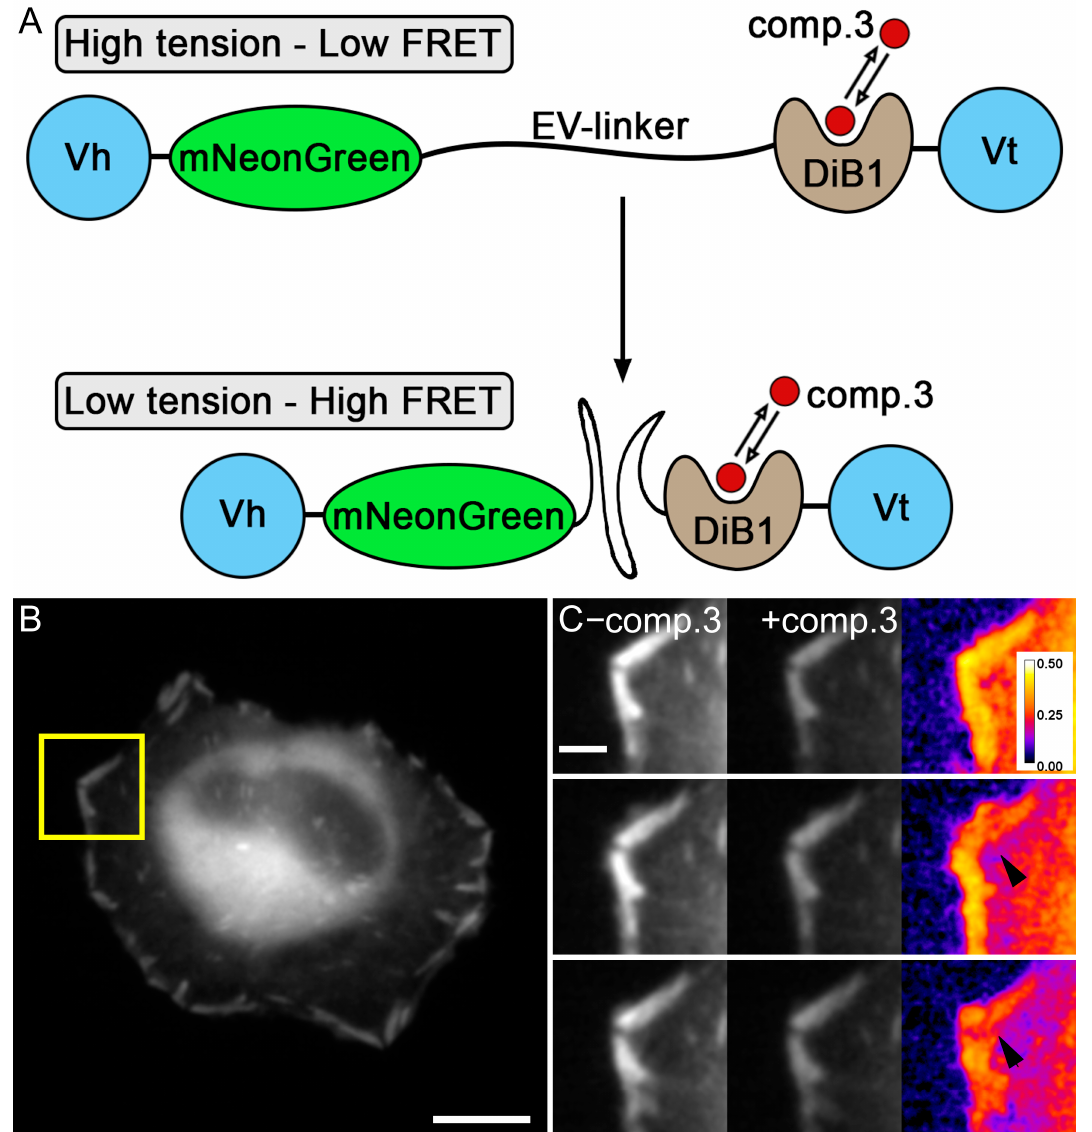
Figure 4. Modified tension sensor based on a new FRET pair with the modulated acceptor. ( A ) Scheme of the new tension sensor and its working mechanism. ( B ) Widefield image of live HeLa Kyoto cells transiently transfected with modified tension sensor construct; scale bar is 20 μ m. ( C ) Widefield images of the region indicated by a yellow rectangle on panel ( B ) before, after compound 3 addition, and FRET efficiency images of the same region over time (pseudocolor—FRET efficiency); scale bar